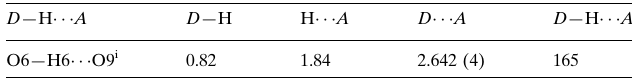
Hydrogen-bond geometry (A˚ , (cid:4)